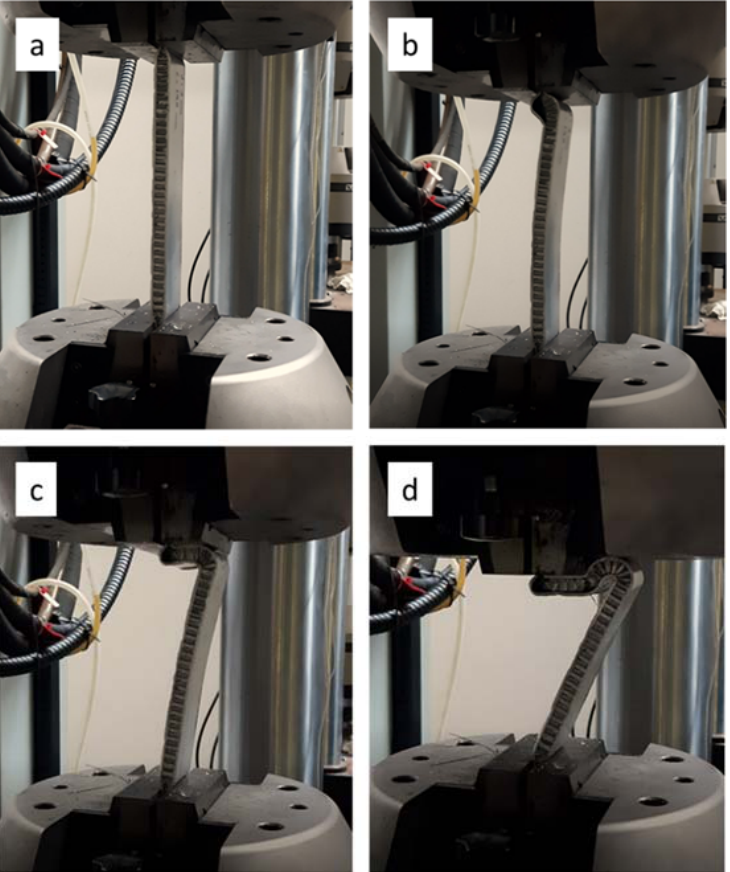
Figure 5. Load sequence during experimental tests: ( a ) test initiation; ( b ) plastic hinge formation; ( c ) core/skin debonding propagation; ( d ) post ‐ collapse configuration.